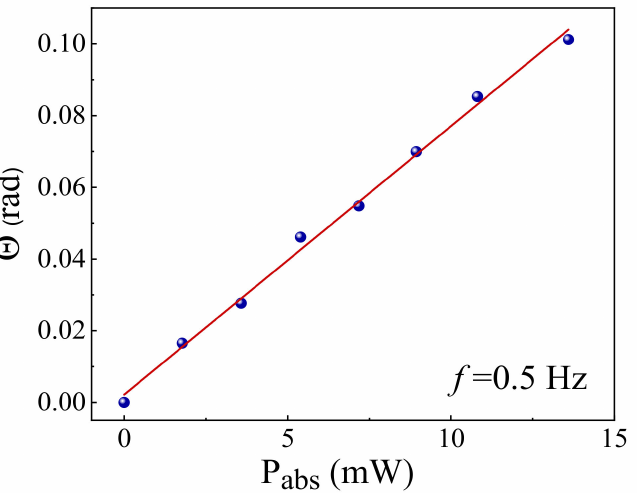
Figure 10. Phase shift ( Θ ) as a function of the absorbed excitation laser power ( P abs ) by the PMZE + 0.4 TiO 2 sample. The red line is the best linear fitting of the data. All doped samples presented similar graphics.